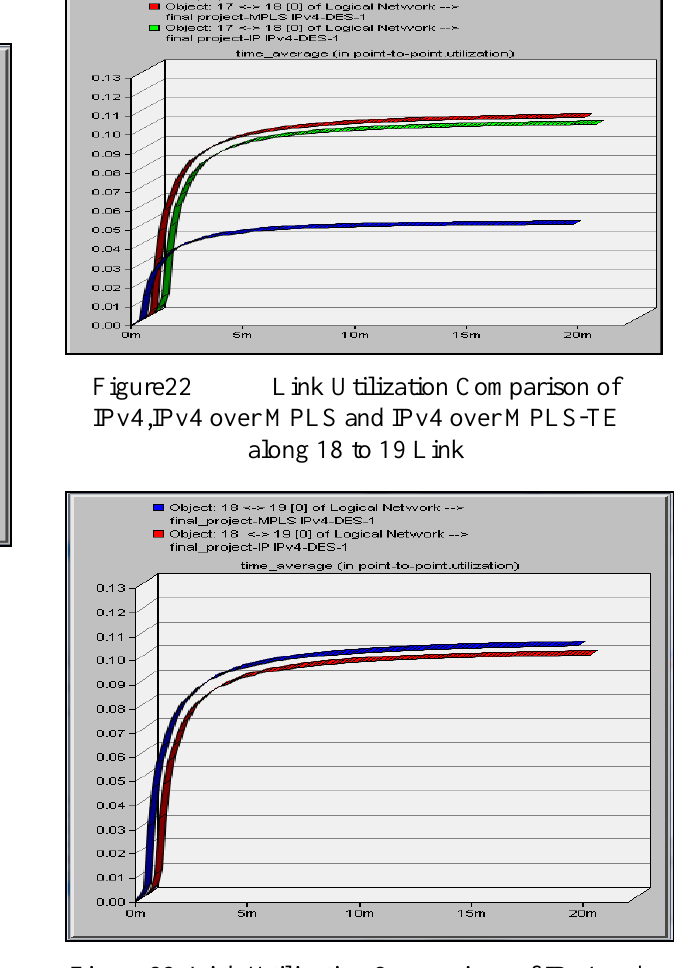
Figure 23 Link Utilization Comparison of IPv4 and MPLS IPv4 along 18 to 19